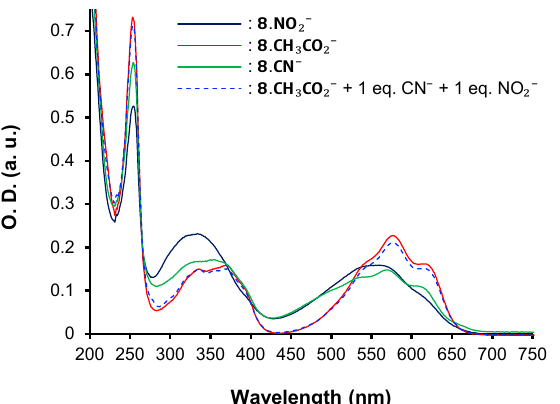
Figure 8. Competitive UV–vis titration assays upon addition of 1 equivalent of NO 2 − and CN − to 8.CH 3 CO 2 − .